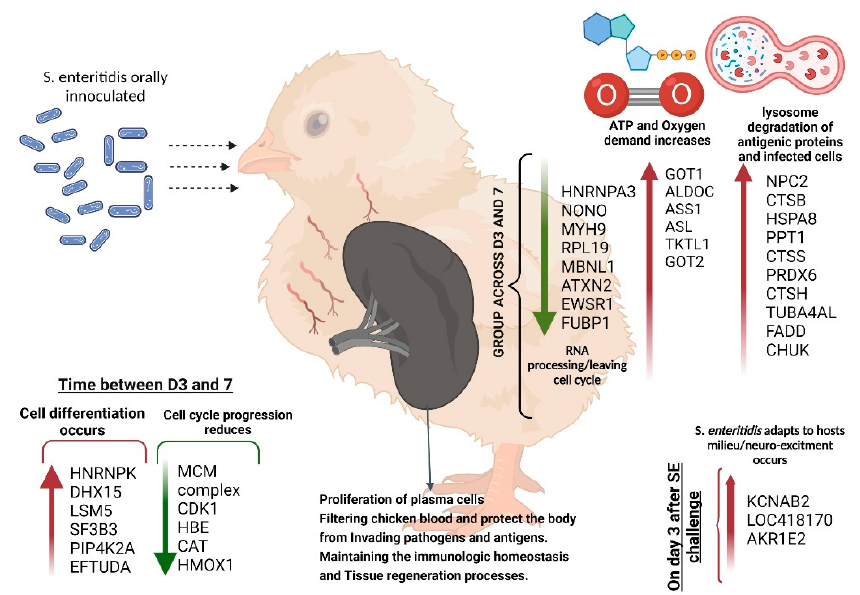
Figure 2. Diagram illustrating the overall signature of changes in spleen proteins between day 3 and 7 post-hatching of broilers and the impact of Salmonella challenge. Red arrows pointing up indicate an increase, whereas the green arrow pointing down denotes a decrease in protein abundance.